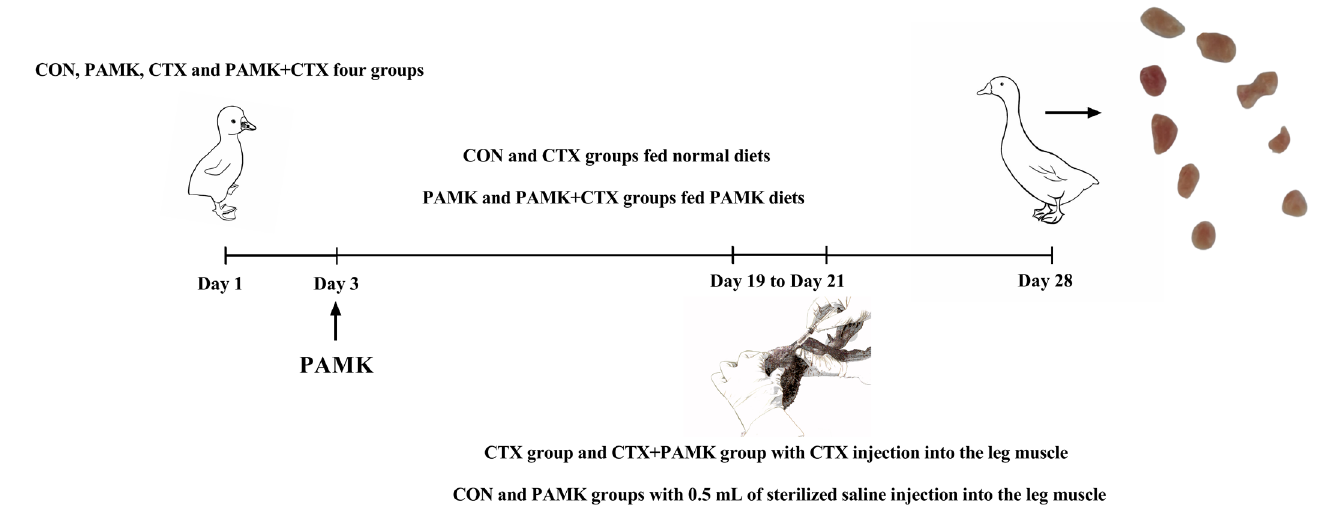
Figure 1. Schematic outlines of the experimental approaches tested in goslings.